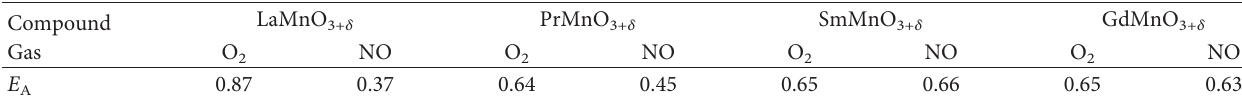
Table 3: The activation energies for the reduction of oxygen and nitric oxide in the temperature interval 200 to 400 ° C given in eV. The activation energy is highest for the end member LaMnO 3+d in the oxygen-containing atmosphere. The activation energies in the oxygen- containing atmospheres are almost the same for the three other manganite-based